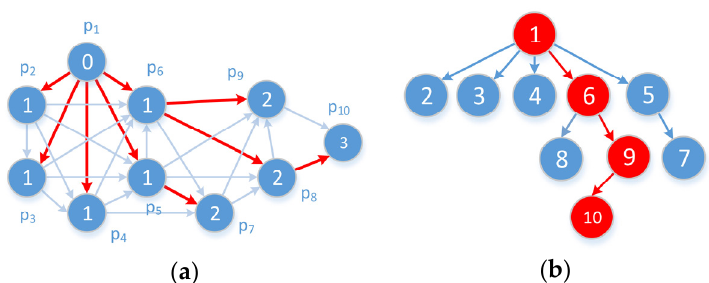
Figure 6. ( a ) The process of the breadth-first search. ( b ) The breadth-first spanning tree.